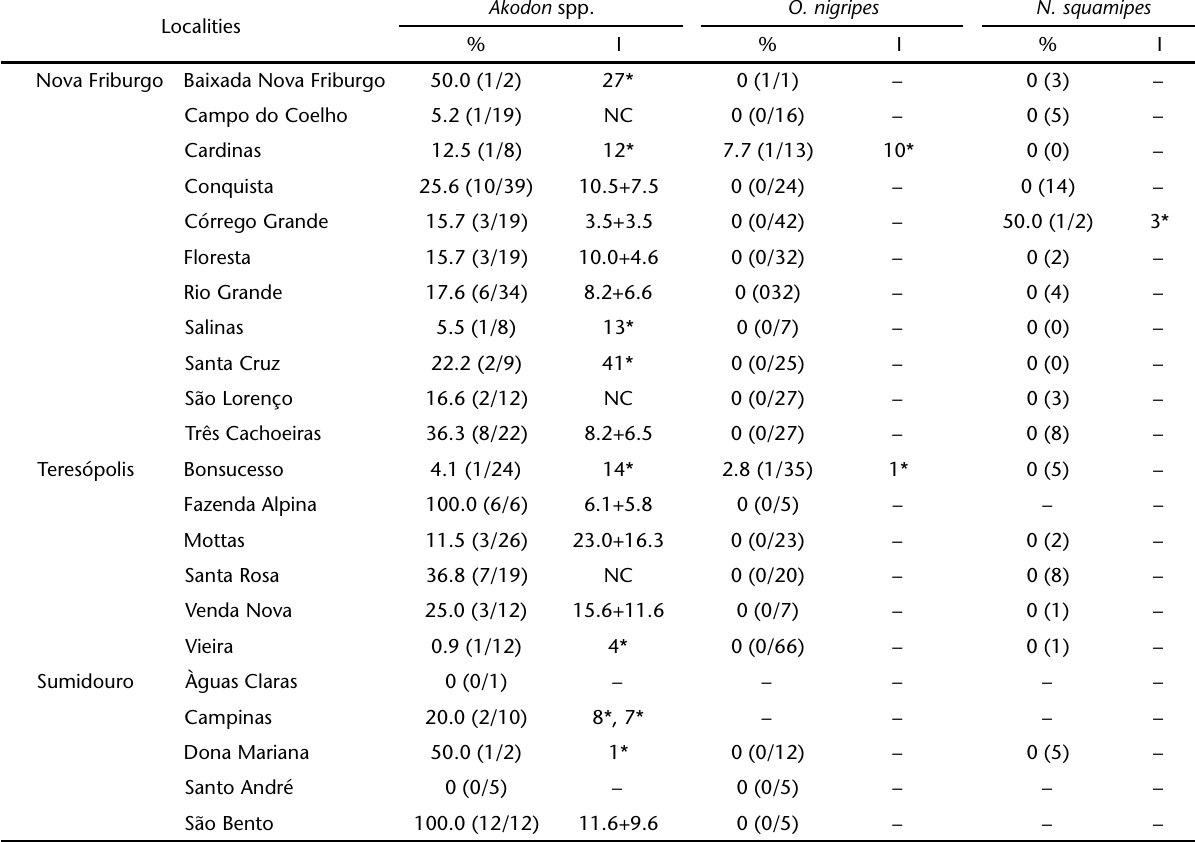
Table I. Canaania obesa prevalence (%) and intensity of infection (I) in Akodon spp., O. nigripes , and N. squamipes naturally infected collected at municipalities of Nova Friburgo, Teresópolis and Sumidouro, Rio de Janeiro State, Brazil from 2000 to 2002.